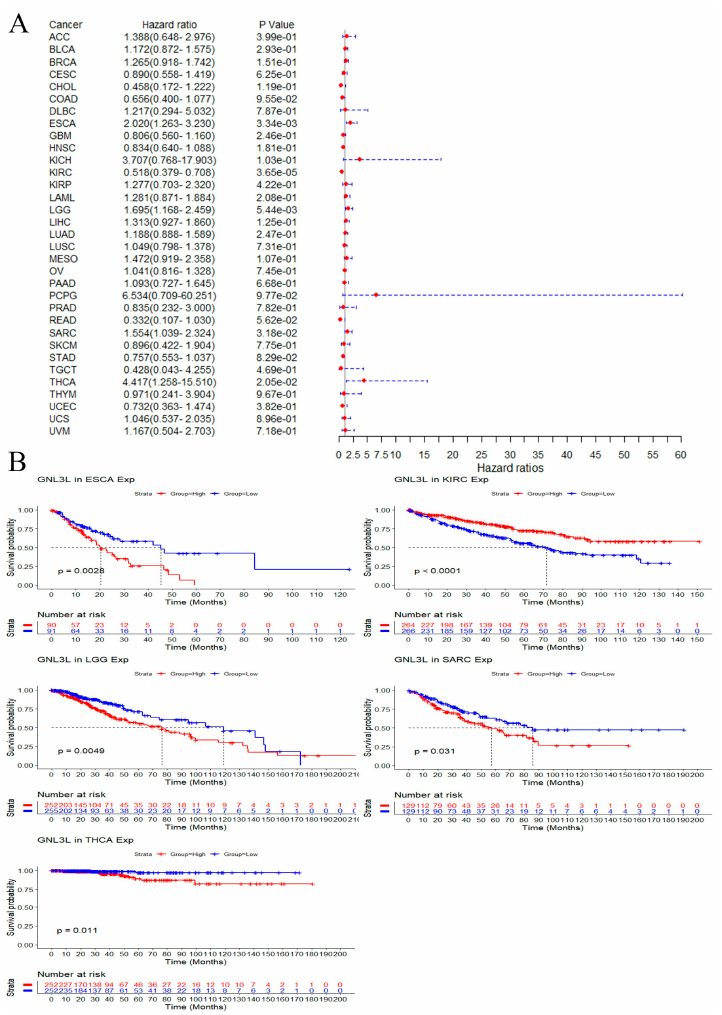
Figure 5. Correlation of GNL3L expression with OS in patients. ( A ) Forest plot of the OS risk ratio of GNL3L in 33 cancers. ( B ) Kaplan − Meier survival curves for patients with ESCA, KIRC, LGG, SARC, and THCA malignancies stratified by GNL3L expression levels.